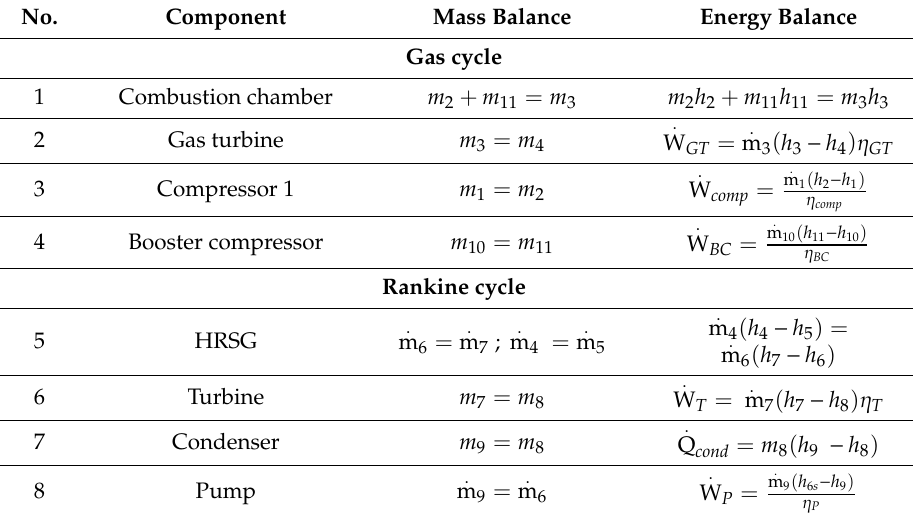
Table 2. Equations of mass and energy balances for GT-HRSG combined system